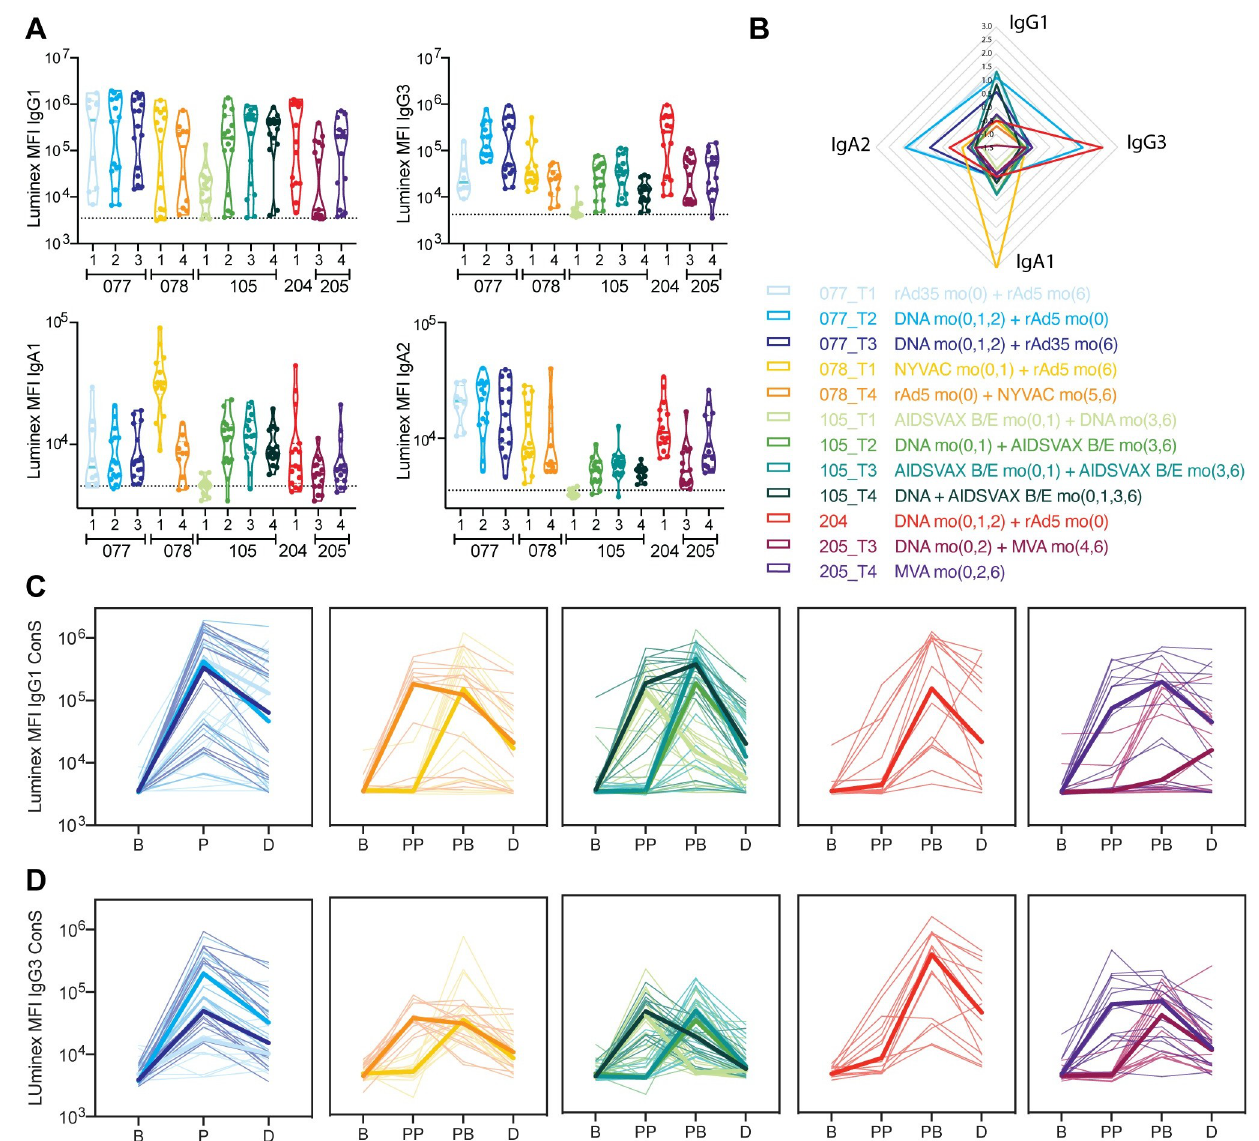
Fig 1. Subclasses/isotypes are tuned differentially across vaccine regimens. Plasma samples were assayed with a customized Luminex assay against gp140 ConS antigen and IgG1, IgG3, IgA1 and IgA2 relative titers in mean fluorescence intensity (MFI) are depicted here. A: The violin plot shows relative antibody titers for each vaccination arm for 5 HVTN trials at the peak immunogenicity time point, lines are indicating median and quartiles. The dotted line indicates placebo levels (averaged across all trials). IgG1, IgG3, IgA1 and IgA2 were measured against gp140 ConS. B: The radar plot shows combined IgG1, IgG3, IgA1 and IgA2 data, data for each subclass were z-scored. Colors correspond to the different trials as indicated in legend. C-D: Each line plot shows IgG1 (C) and IgG3 (D) levels for each trial over time starting at baseline (B), post prime (PP), post-boost (PB) and durability (D) time point. For trial 078, PP indicates Month 1, after the first but before the second prime administration. Different trial arms are depicted in different colors, placebo is indicated in black for panel A. prime with rAd5/rAd35 boost (077 T2 and 077 T3) and DNA prime/rAd5 boost (204) induced elevated IgG3 levels compared to other trials (Fig 1A and 1B). The AIDSVAX prime/DNA boost (105 T1), that induced lower IgG1, also induced low levels of IgG3. Conversely, several trials, including the rAd35 prime/rAd5 boost (077 T1), DNA prime/AIDSVAX boost (105 T2), AIDSVAX prime/AIDSVAX boost (105 T3), and DNA prime/AIDSVAX (105 T4) all induced low levels of IgG3 in the setting of high IgG1 levels.